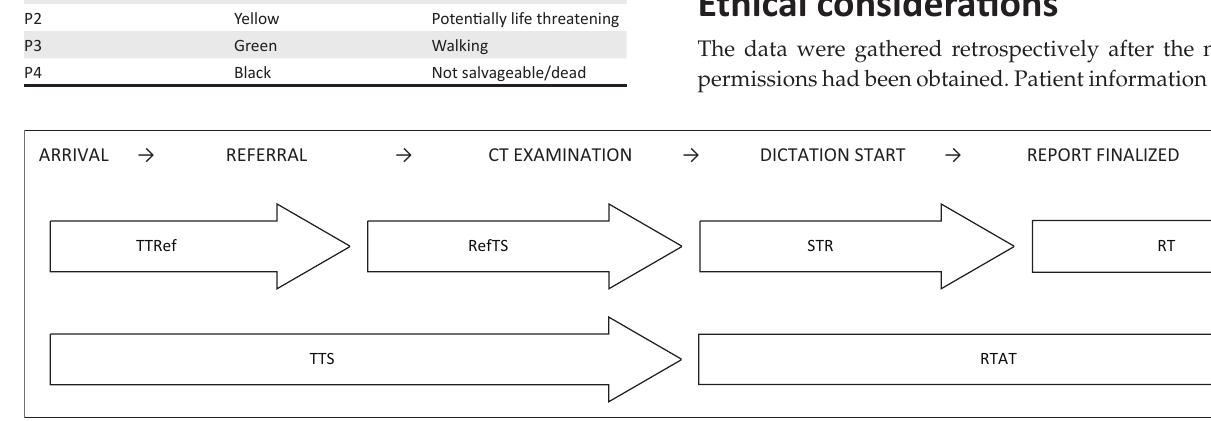
FIGURE 1: The trauma-radiology timeline.